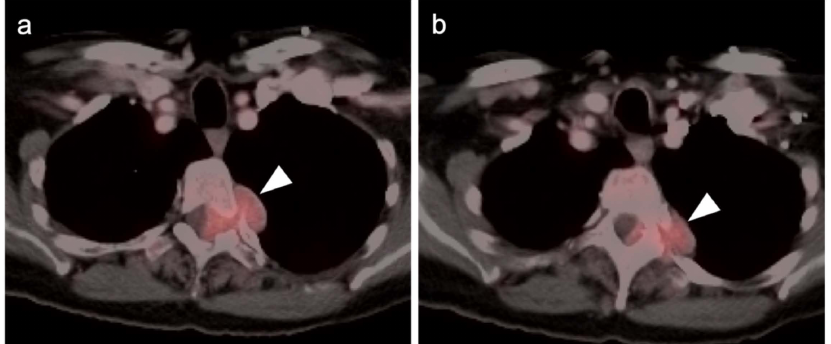
Figure 30. Dumbbell neurofibroma of the thoracic spine. ( a , b ) Axial FDG PET-CT images of the chest show a dumbbell-shaped lesion with an epidural/intraspinous component extending through the lateral recess to an extraspinous component (white arrowheads). As in this case, patients often experience pain and symptoms of spinal cord compression. The lesion was surgically removed and found to be a benign